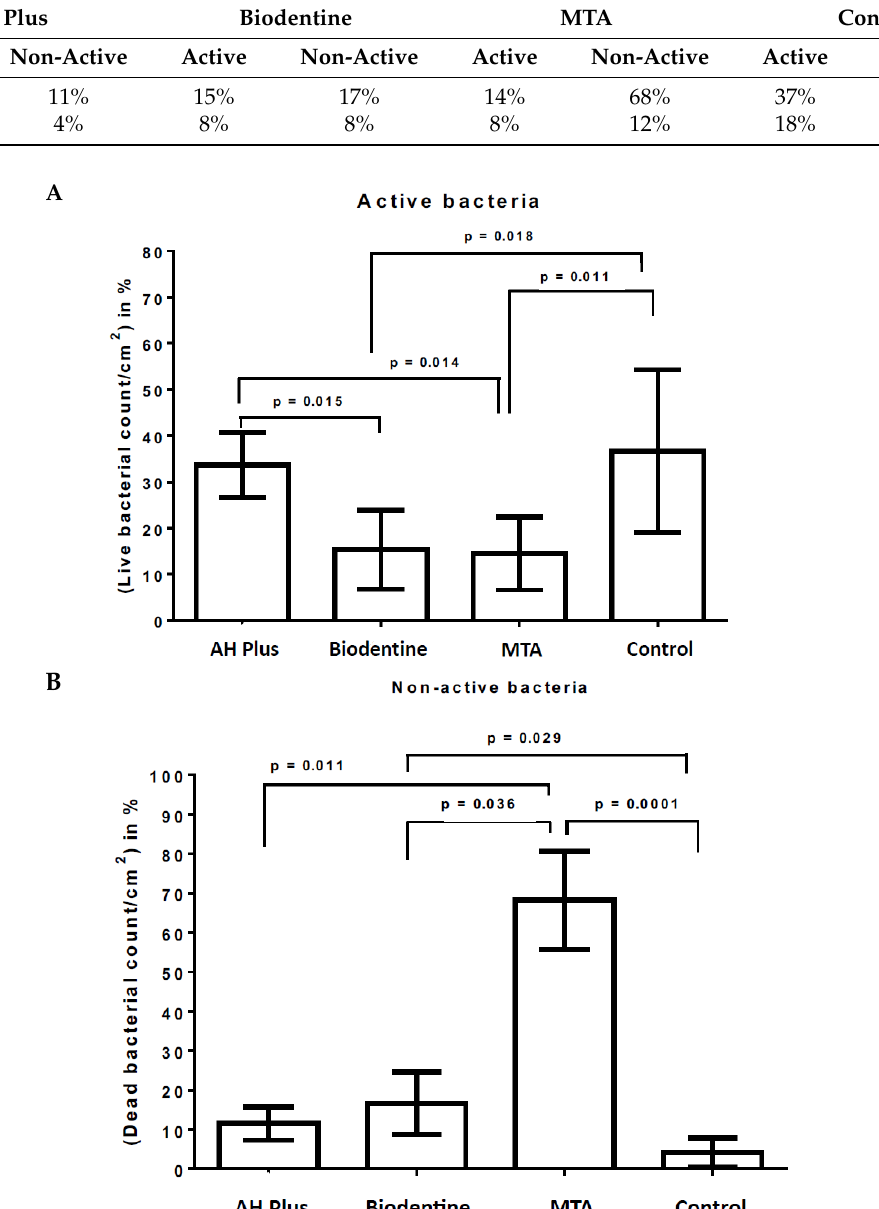
Figure 4. Live/dead staining and fluorescence microscopy. The graphs represent the percentage of “active” oral ( A ) and “non-active” microorganisms ( B ), which were evaluated by the live/dead staining under the fluorescence microscope (FM). Bovine dentin served as a negative control, while AH Plus, Biodentine, and MTA served as material test surfaces. Standard deviations and the p values of the significantly different data are marked on the graphs.